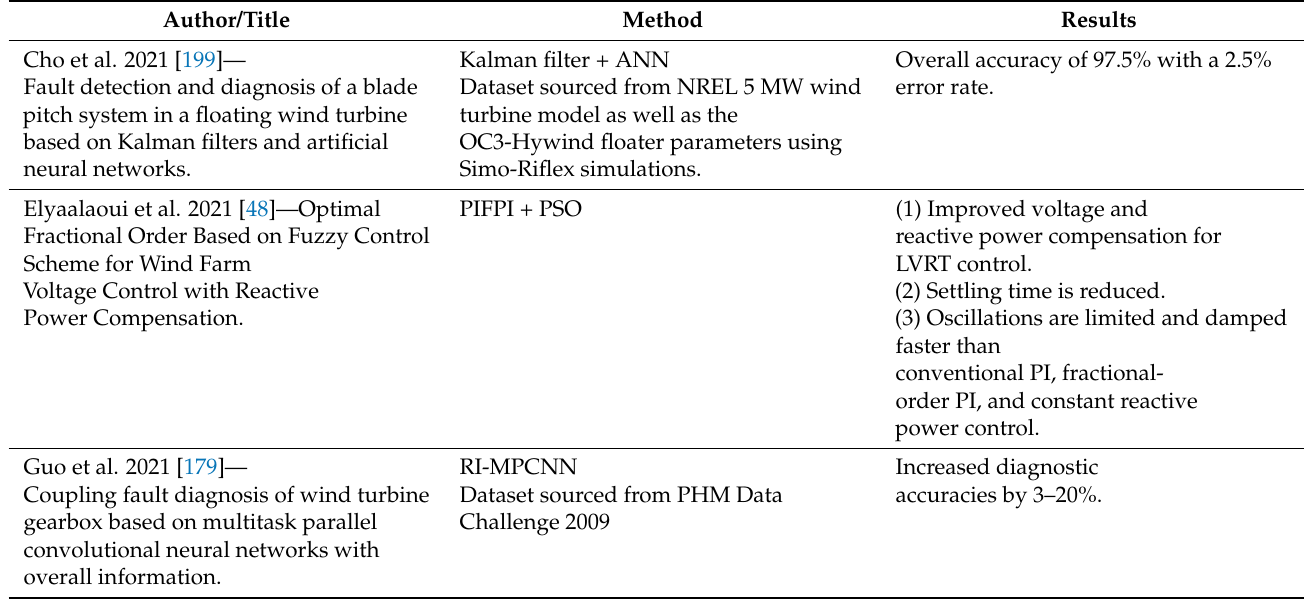
Table A1. AI and ML Algorithms for WF Control Systems